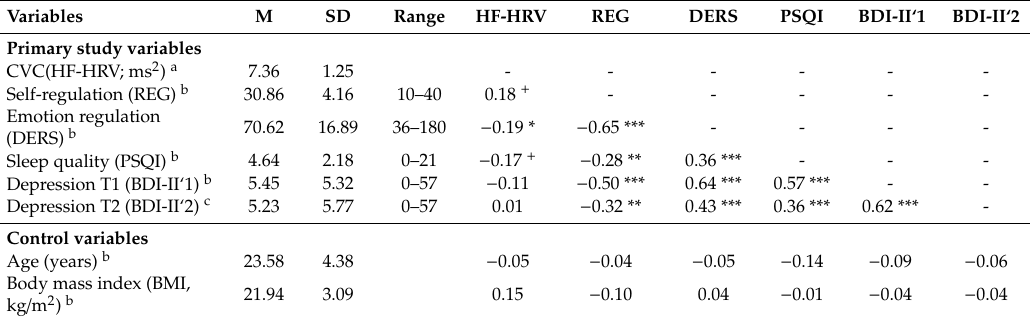
Table 1. Descriptives and zero-order